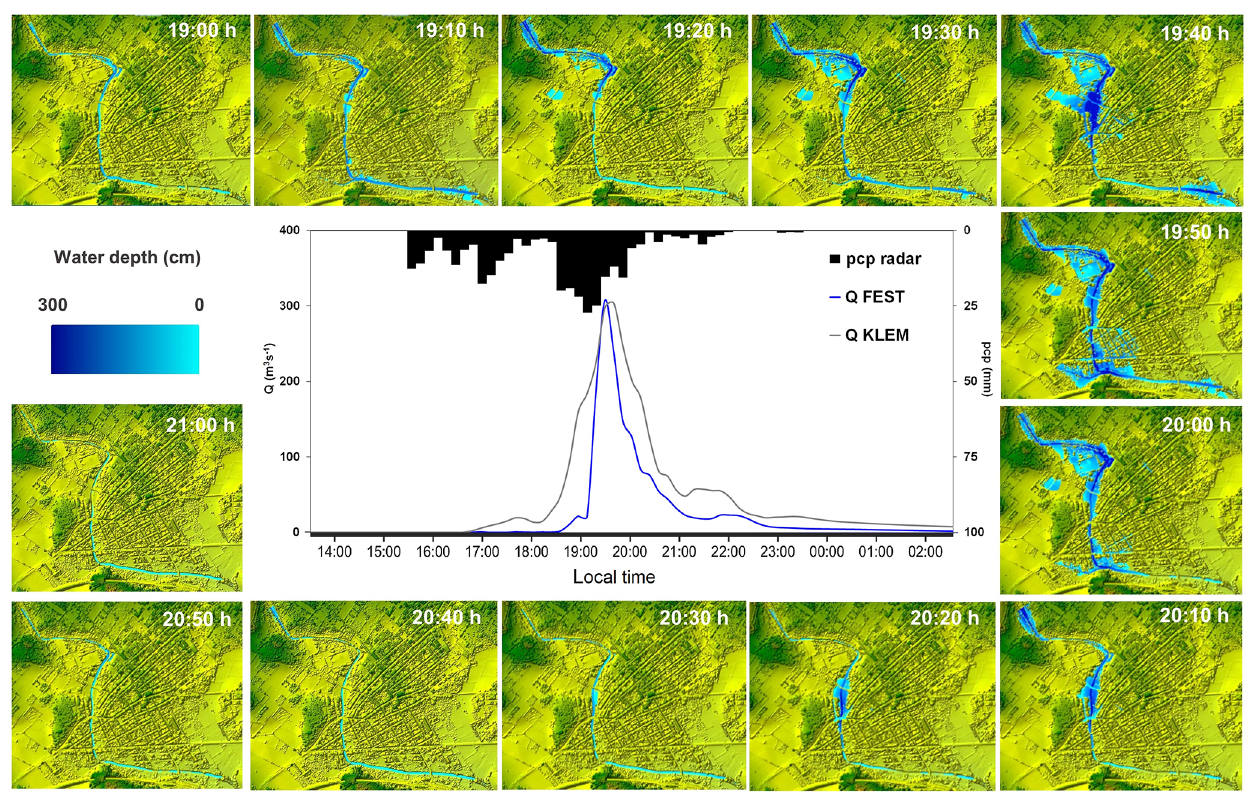
Figure 5. Modelled flash flood hydrographs at the entrance of Sant Llorenç and simulation of the flood peak as it crosses, devastating the town centre between 19:00 and 21:00LT. The pcp abbreviation represents